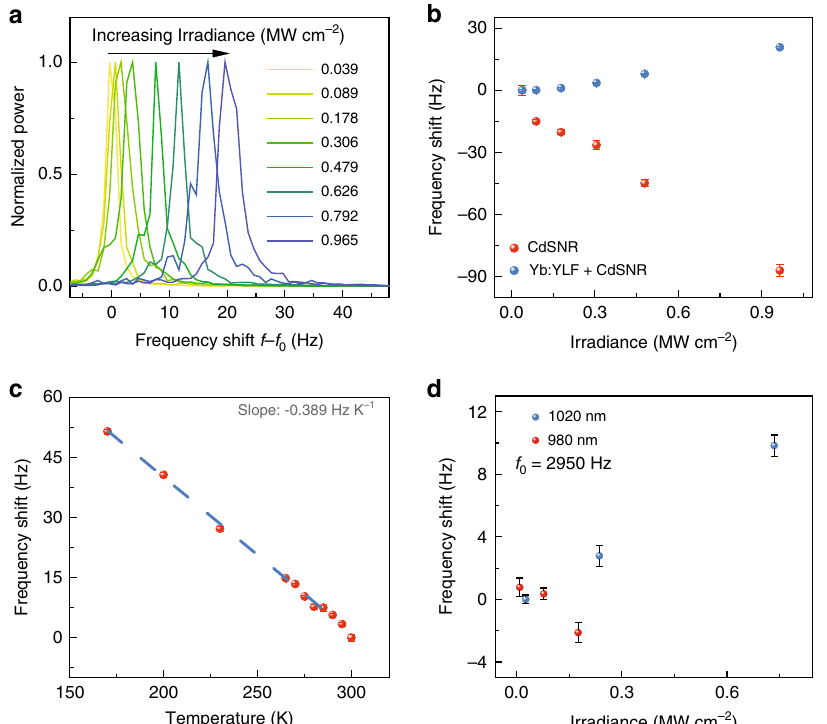
Fig. 2 Eigenfrequency thermometry. a Normalized power spectra for a representative laser refrigeration measurement at each laser irradiance with an ambient reference temperature of 295 K ( f 0 = 3632.2 Hz). b The frequency shift ( f − f 0 ) with laser power at 295 K for both a plain CdSNR (red) and CdSNR with Yb:YLF (blue). Each data point was obtained by taking the mean of peak position obtained from Lorentzian fi ts of six thermomechanical noise spectra and error bars represent one standard deviation. Note that for small standard deviations, the error bars overlap with the data point. f 0 is 3632.2 Hz and 17384.4 Hz, respectively. c Temperature calibration of the CdSNR with Yb:YLF obtained by measuring the frequency shift f − f 0 ( f 0 = 3653.6 Hz) as a function of the cryostat temperature. The data points take into account the uncertainties in measurement by averaging the frequency value obtained from six thermomechanical noise spectra recorded at the given temperature. The error bars represent one standard deviation. d Eigenfrequency measurements using co-focused 980 nm and 1020 nm lasers. The data points take into account the uncertainties in measurement by averaging the frequency value obtained from six thermomechanical noise spectra recorded at the given laser power. The error bars represent one standard